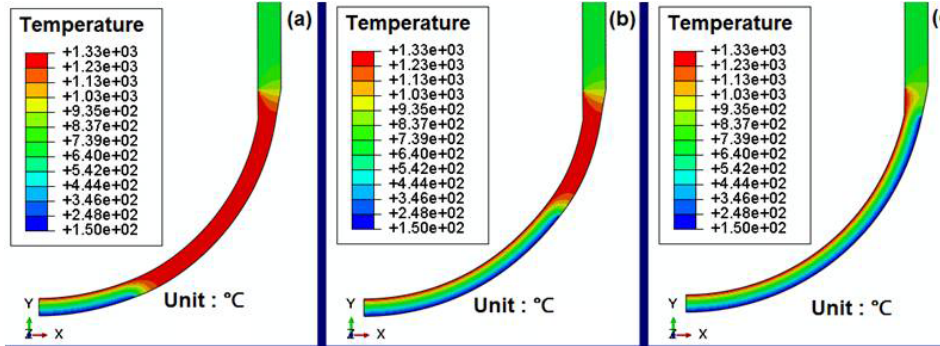
Figure 3. Temperature contours comparison for RPVs with various water levels.